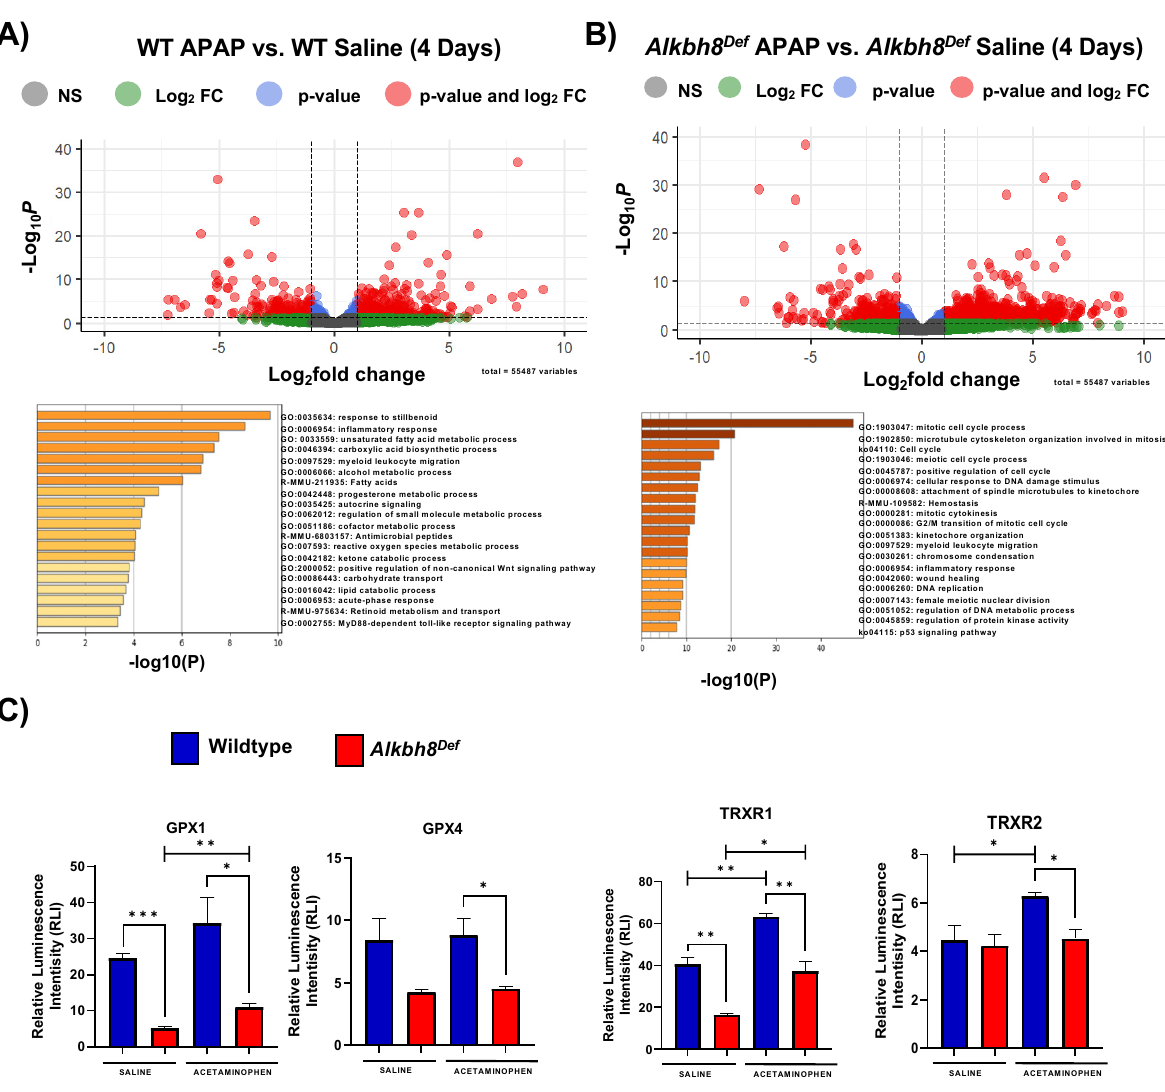
Figure 6. Writer deficient mice have altered gene expression and response due to altered epitranscriptomic response. WT (N = 6) and Alkbh8 Def (N = 6) mice were IP injected daily with APAP. ( A – C ) Tissue was harvested at day 4 and RNA and protein were purified for analysis. ( A , B ) Enhanced volcano plots for mRNA-seq data were generated for each of the comparisons and metascape analysis was performed for log 2 FC > 2.0 and p adj. values ≤ 0.05. ( A ) WT APAP vs. WT Saline and ( B ) Alkbh8 Def APAP vs. Alkbh8 Def Saline. ( C ) Selenoprotein levels were evaluated using the ProteinSimple WES system. Statistical significance (N = 3) was determined using an unpaired t -test with (* p < 0.05, ** p < 0.01, and *** p <